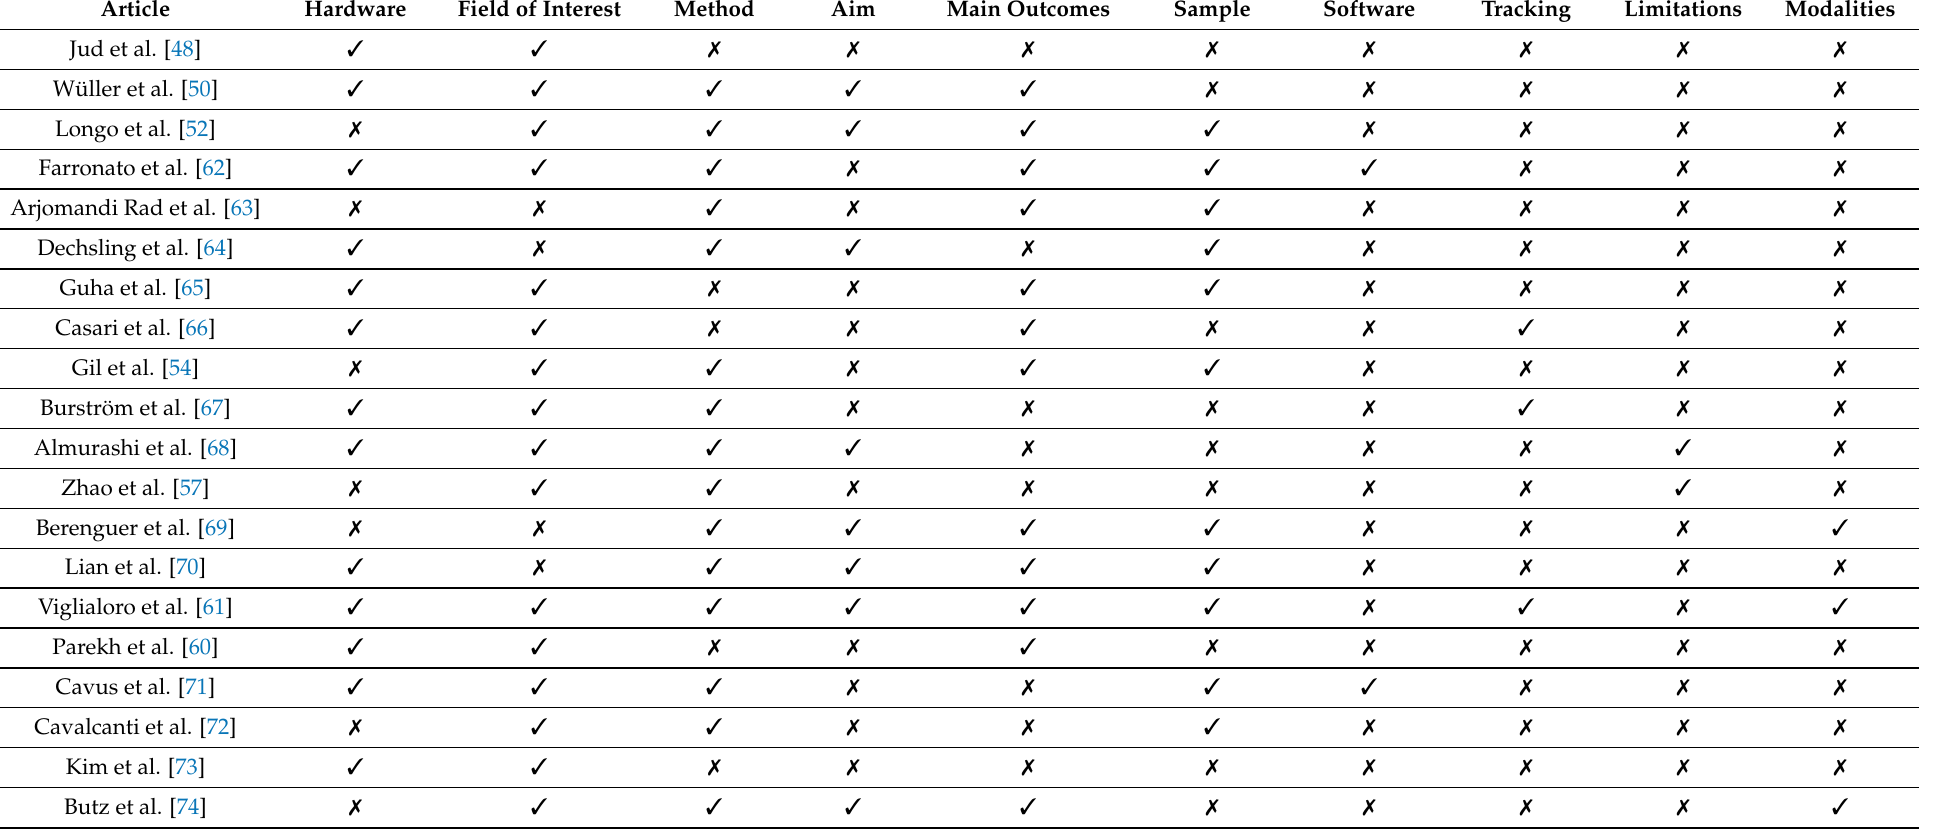
Table 1. Criteria for healthcare-oriented AR review